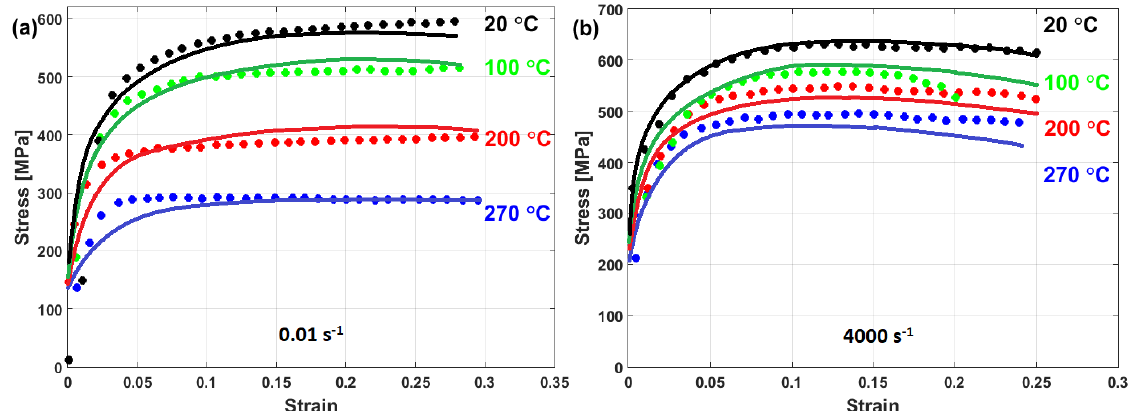
Figure 31. Experimental stresses (markers) compared to predicted stresses (solid lines) using a modified JC model that was presented by Chen et al. [82] for 7050-T745 aluminum alloy at high strain rates and different temperatures ( a ) 0.01 s −1 and ( b ) 4000 s −1 .